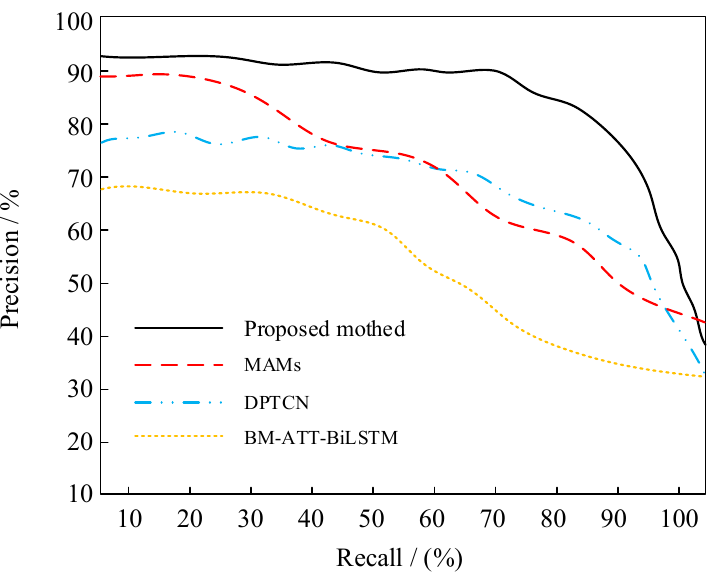
Figure 13. P–R curve of different methods under CNT dataset. Figure 13. P – R curve of different methods under CNT dataset.